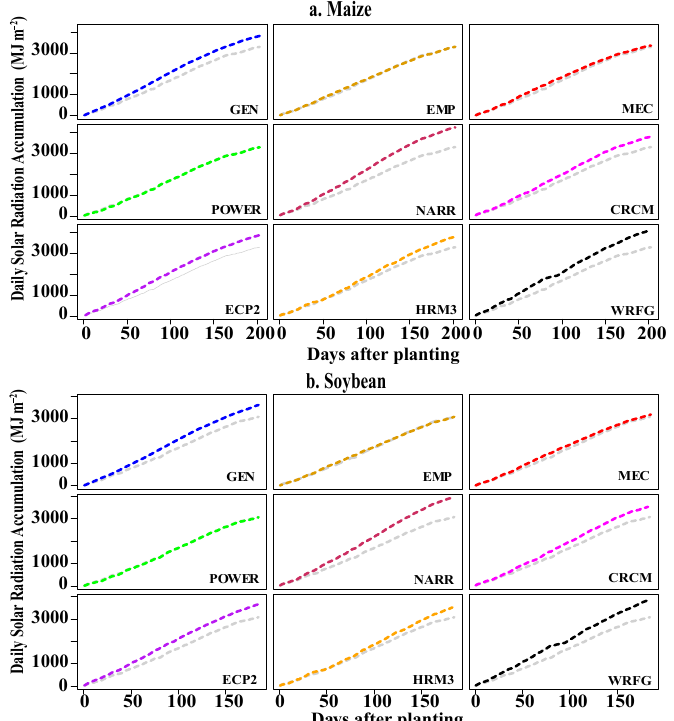
Figure 5. Growing season estimated (color) and observed (gray) accumulated daily solar radiation (SRAC) during 1993 for ( a ) maize and ( b ) soybean. See Figure 2 for definition of abbreviations. For both crops, planting occurred on April 1. For reference, the timing of crop stages for the 1993 simulations using observed radiation, in terms of days after planting, for maize (soybean) was 2 (11) for emergence, 86 (74) for anthesis and 172 (142) for maturity.